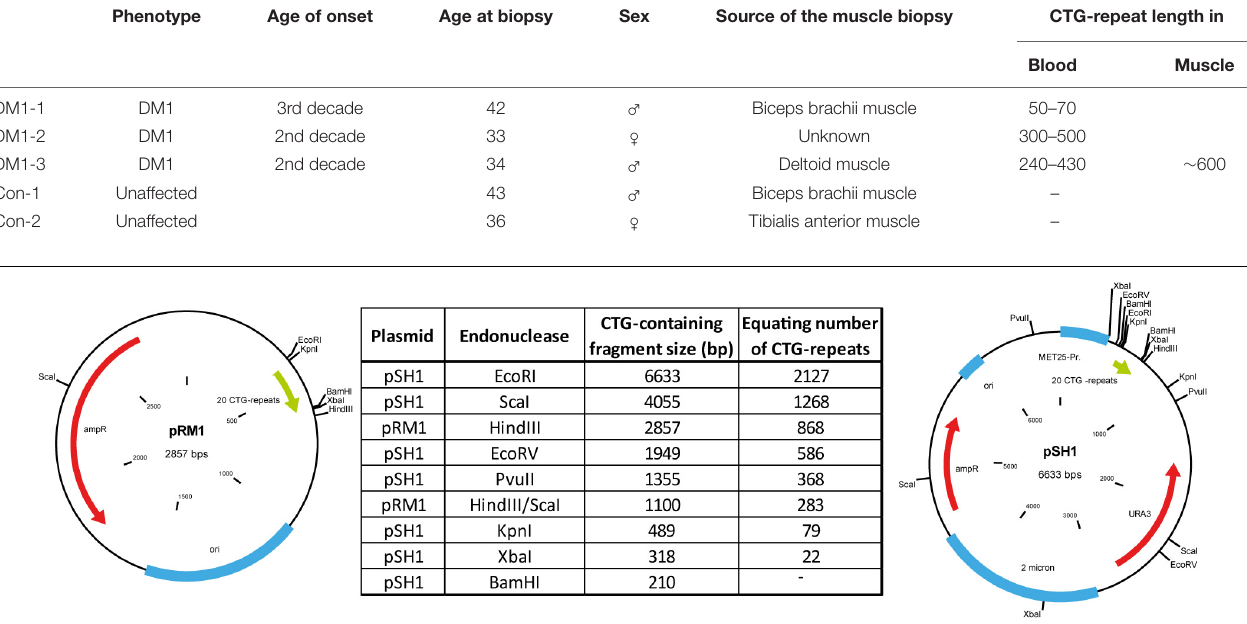
FIGURE 1 | Plasmids used to create the size marker by restriction digest with endonucleases and the resulting sizes of the CTG-repeat containing